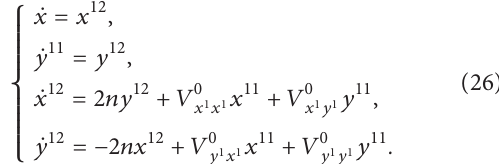
Figure 3: Zoomed part of Figure 2 near L